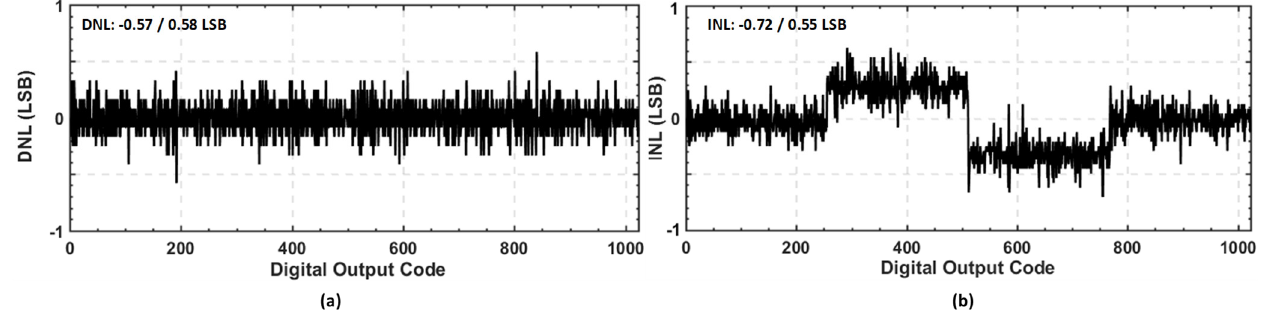
Figure 15. Measured static performance: ( a ) Differential non-linearity (DNL); ( b ) Integral non-linearity (INL).